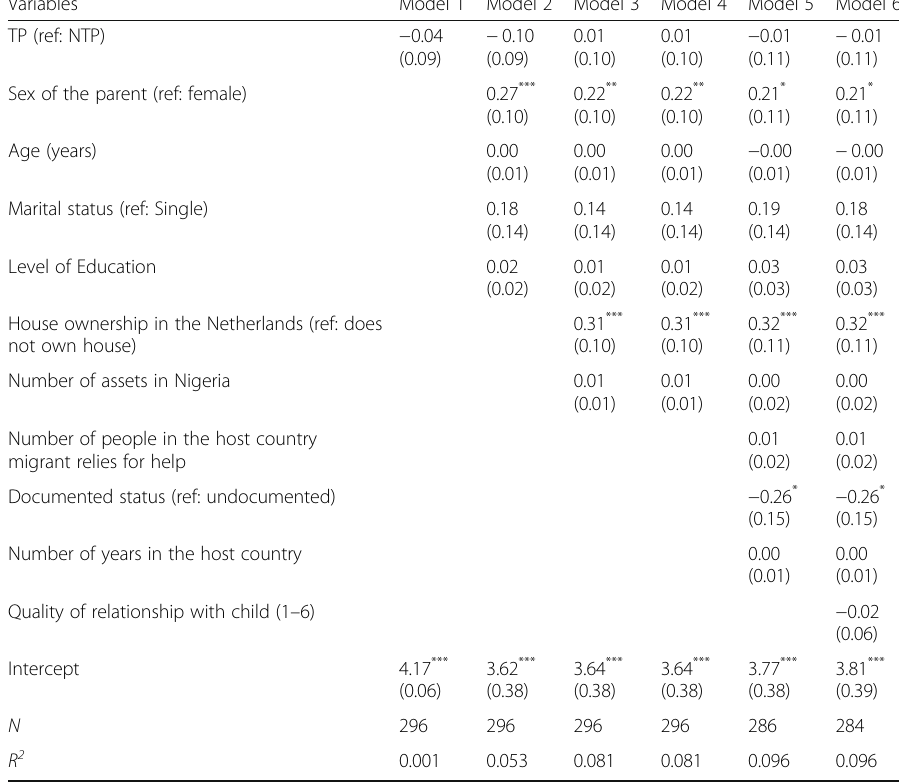
Table 4 Ordinary Least Squares regressions predicting self-assessed Health, The Netherlands